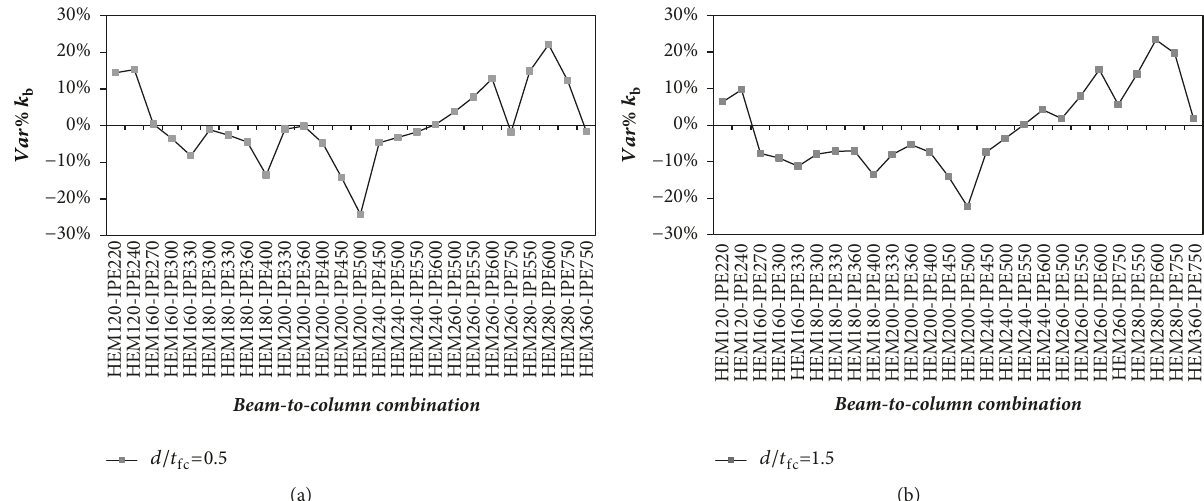
Figure 13: Accuracy of the approximate equations in terms of percentage of difference for selected values of the ratio 𝑑/𝑡 fc : normalized stiffness